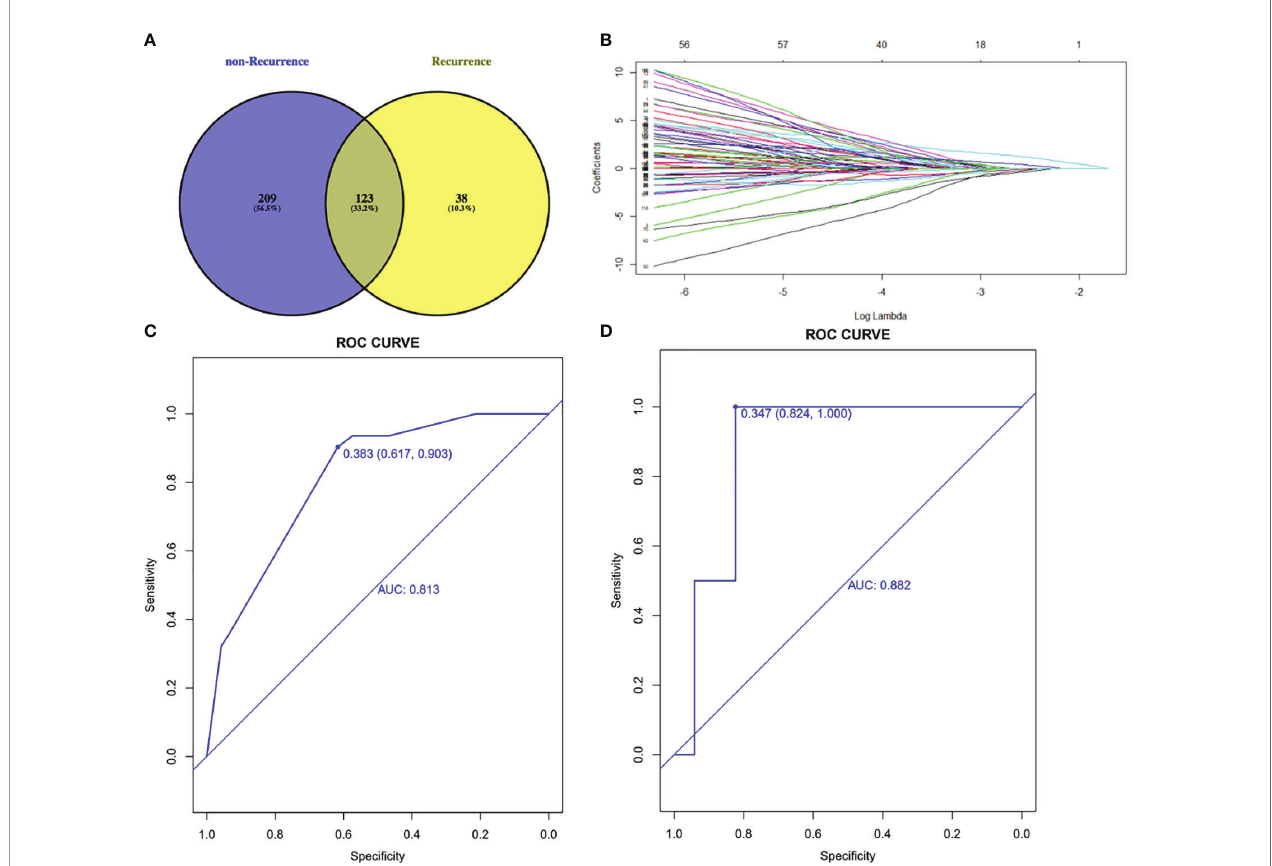
FIGURE 2 | Lasso-Cox regression model. (A) 123 common genes mutated inboth recurrence and non-recurrence group. (B) Least absolute shrinkage andselection operator (LASSO)regression model. (C) ROC curve of training cohort. (D) ROC curve of validation cohort. AUC, area under curve; ROC, receiver operating